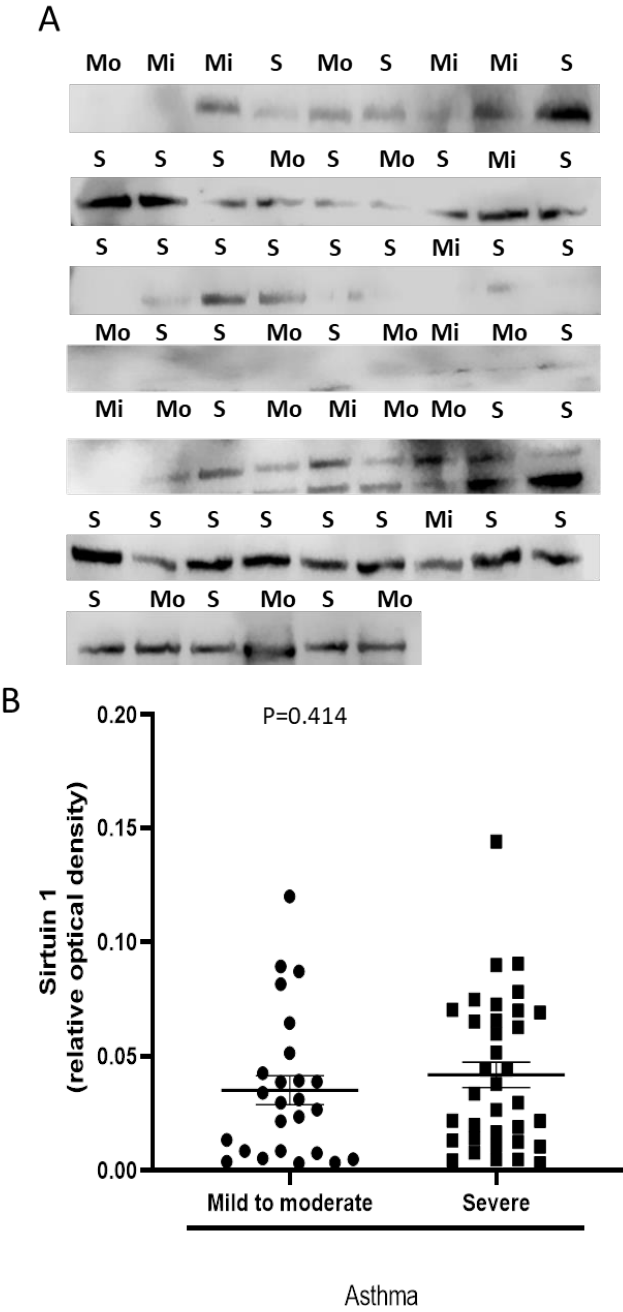
Figure 1. Sestrin 2 levels in patients with mild to moderate and severe asthma in cell pellets ( A ) and sputum supernatants ( B ). For data, see the table.